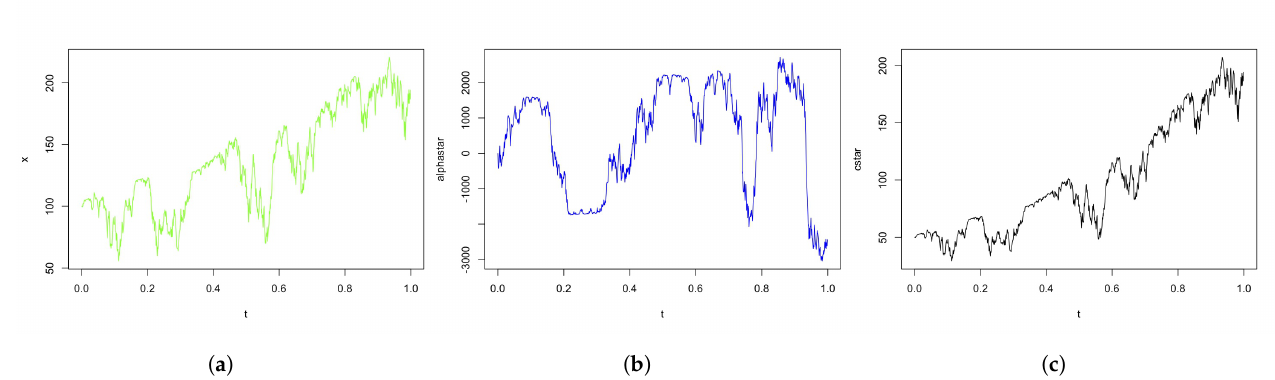
Figure 5. The wealth process with the parameters α and c when σ = 0.1, r = 0.01 and κ = 5 with n = 1000. ( a ) The wealth process X ∗ . ( b ) Optimal investment α ∗ . ( c ) Optimal consumption c ∗ t t t